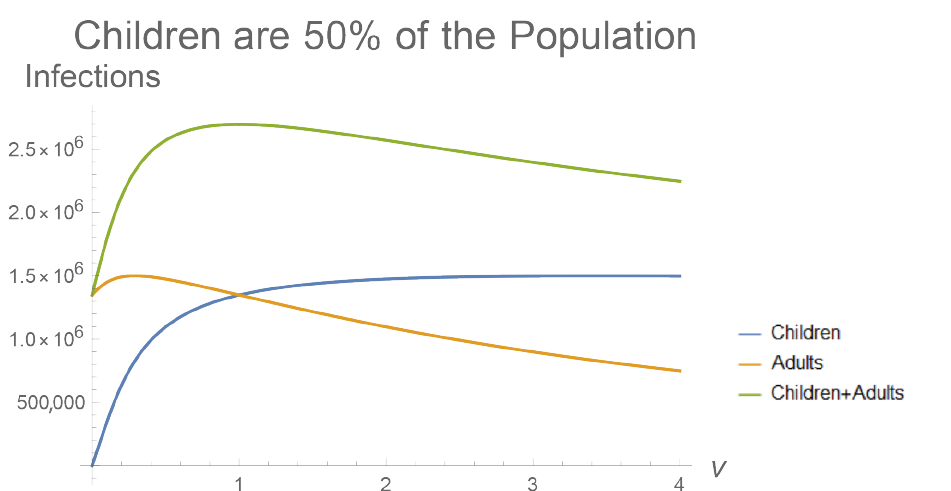
Figure A2. The values of I ∗ a and I ∗ from the age-structured model plotted against ν , the relative k susceptibility of children, who make up half the population. The curves are qualitatively similar to those in Figure 3 but the relationships are more pronounced since children make up a greater share of the population.